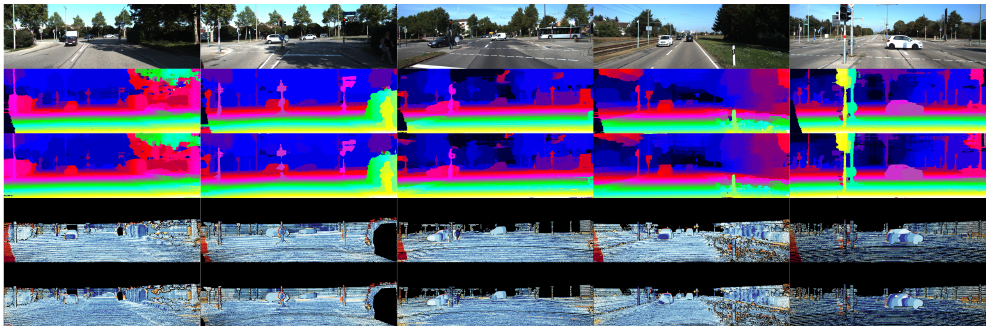
Figure 9. Some results of our method for testing image in KITTI 2015 dataset [38]. Images from top to bottom: reference image, disparity images based on feature maps extracted by CNN and handcrafted feature, error maps of corresponding disparity